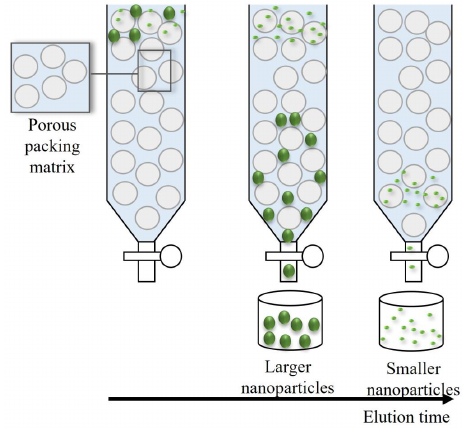
Figure 5. Representative scheme of SEC.